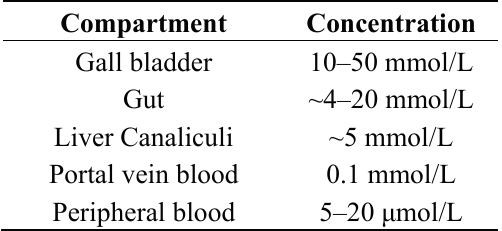
Table 2. The concentrations of bile salts in human body